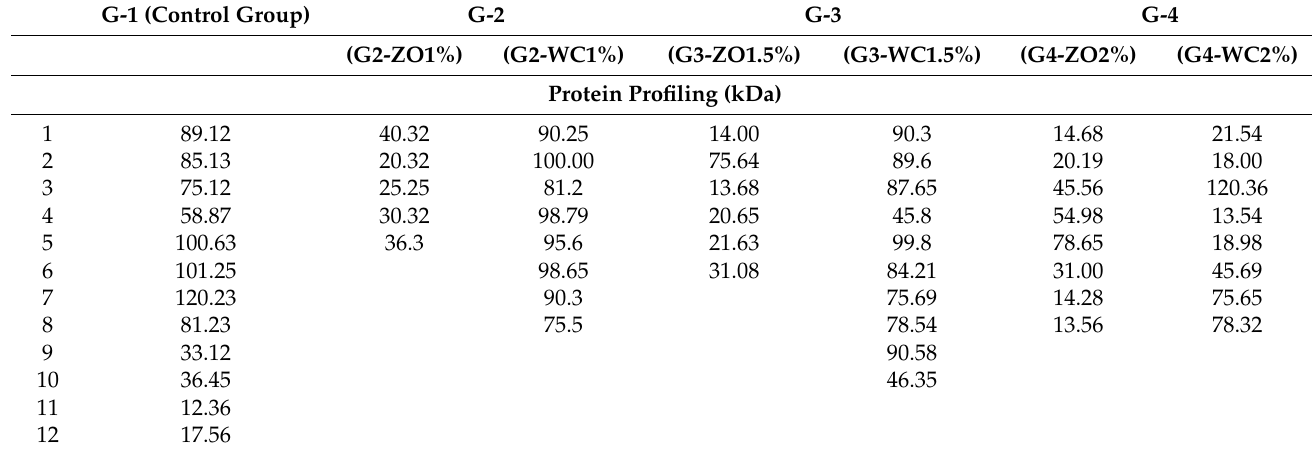
Table 4. Protein profiling of the groups.